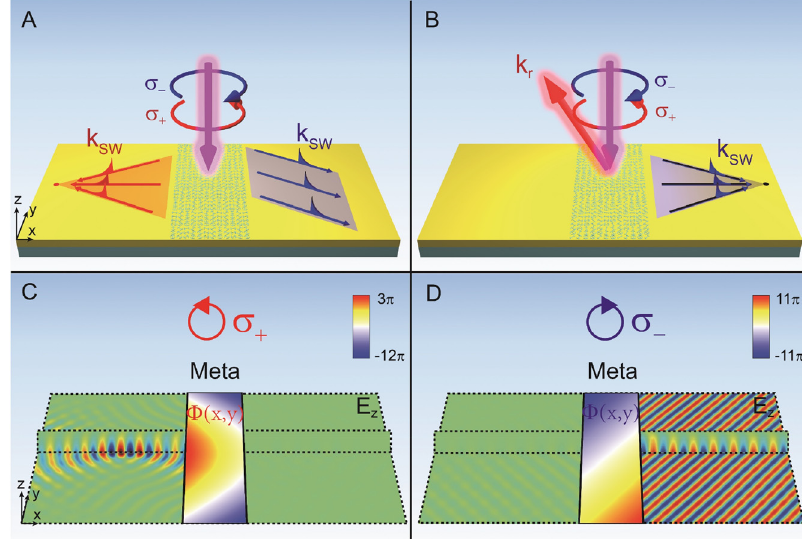
Figure 1: Physical concept and theoretical veri fi cations on ideal models.